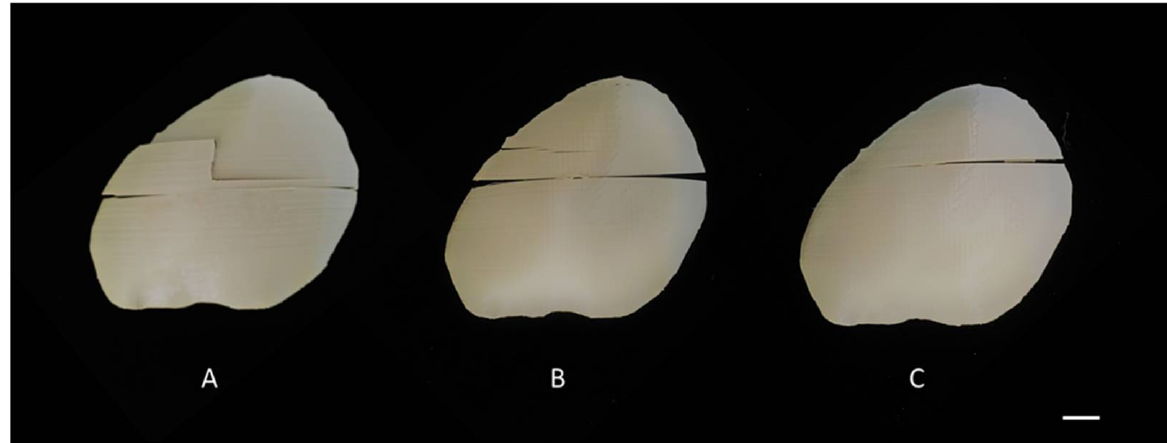
Figure 3. Different fracture patterns in the material extrusion 3D-printed PEEK cranial patient-specific implants: ( A ) Class 1